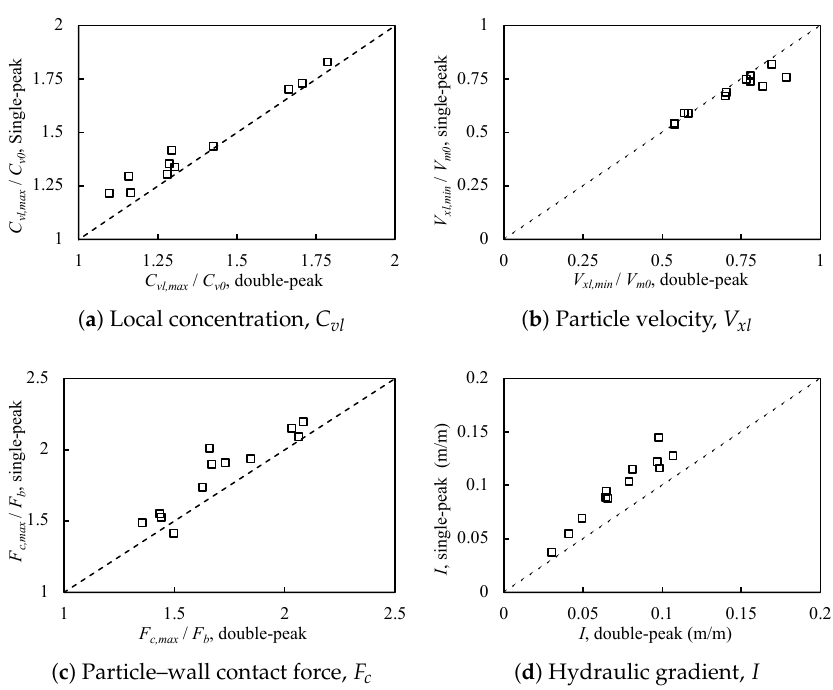
Figure 16. Comparison of maximum C vl / C v 0 , minimum V xl / V m 0 , maximum F c / Fb and overall I , single-peak versus double-peak